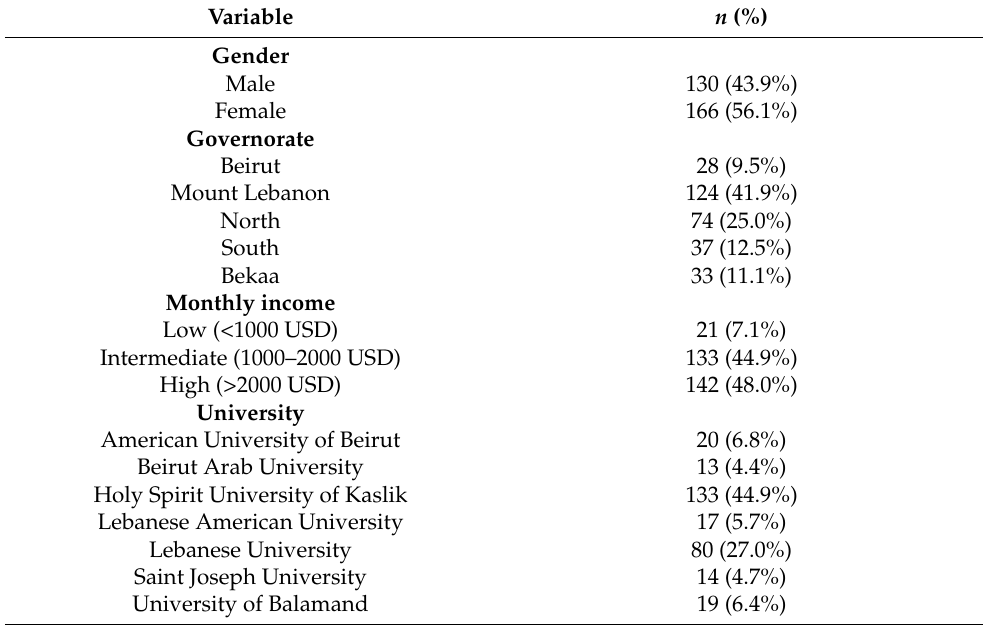
Table 1. Sociodemographic and other characteristics of the participants ( n =